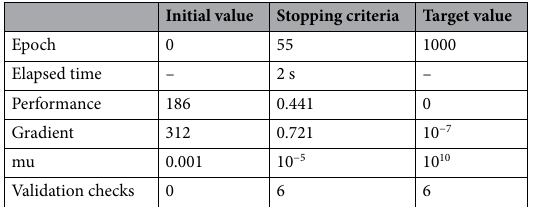
Table 2. Model parameters. Data division: random; training function: Levenberg–Marquardt function; performance function: